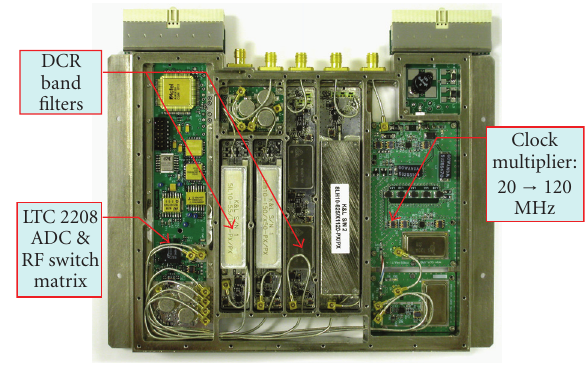
Figure 2: Direct conversion Receiver (DCR) System including analog bandpass filters and analog-to-digital